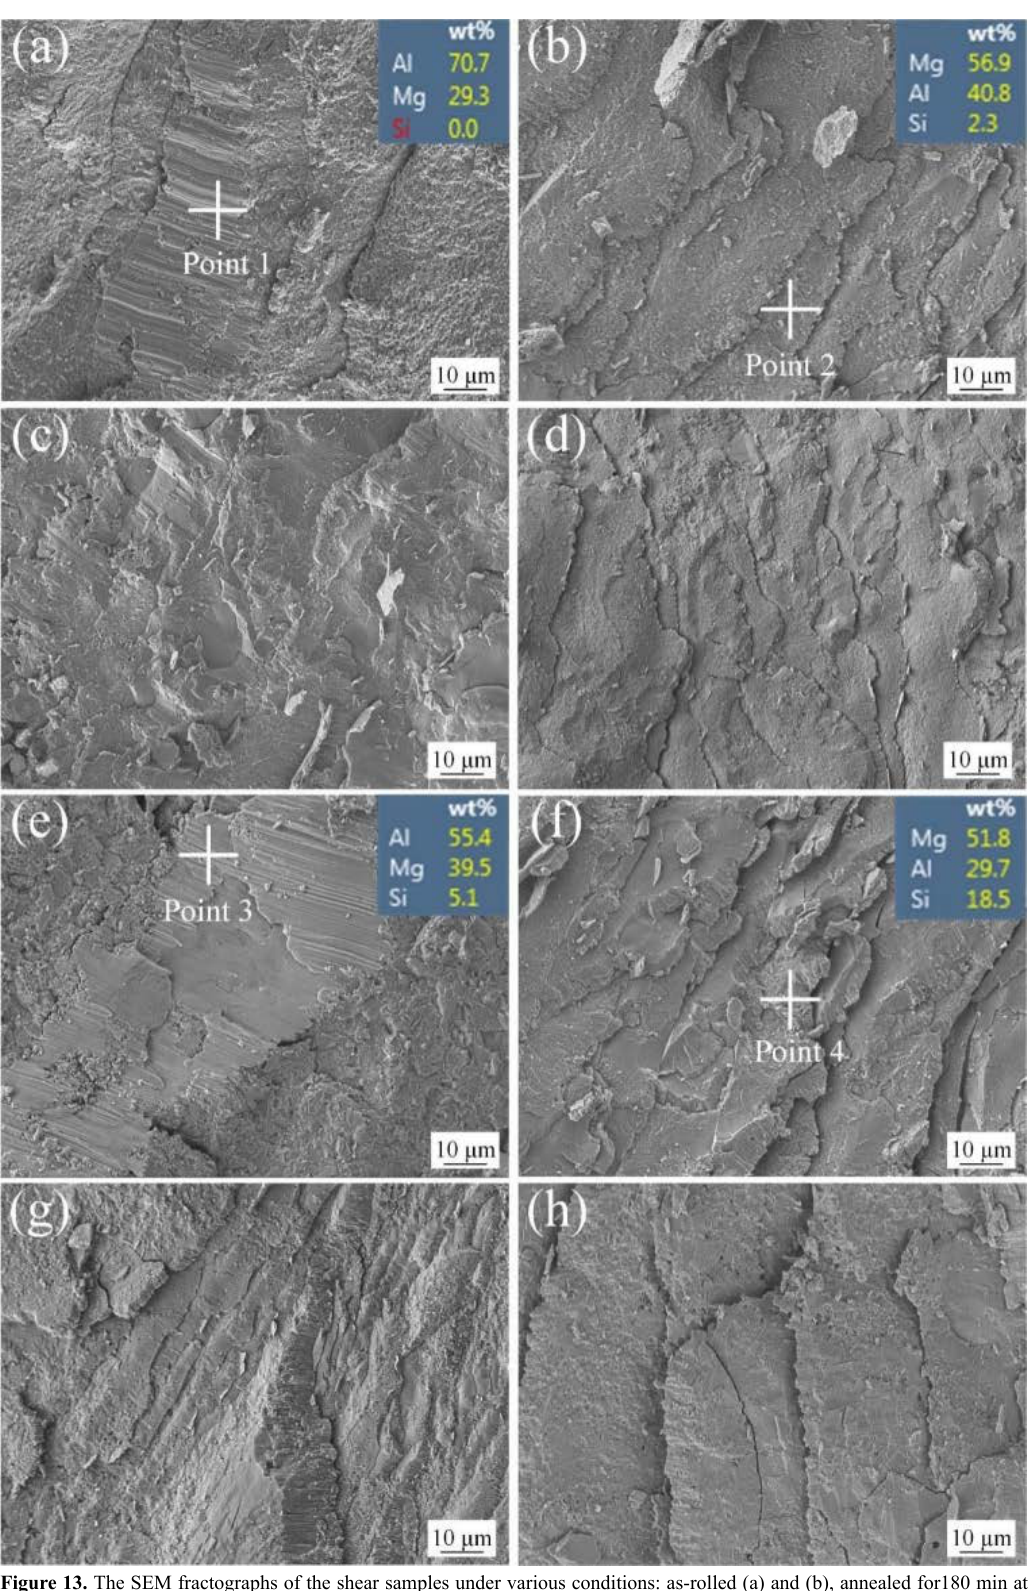
Figure 13. The SEM fractographs of the shear samples under various conditions: as-rolled (a) and (b), annealed for180 min at 200 ºC (c) and (d), 300 ºC (e) and (f), 400 ºC (g) and (h), where (a), (c), (e) and (g) show the A356 side while (b), (d), (f) and (h) show the AZ31B